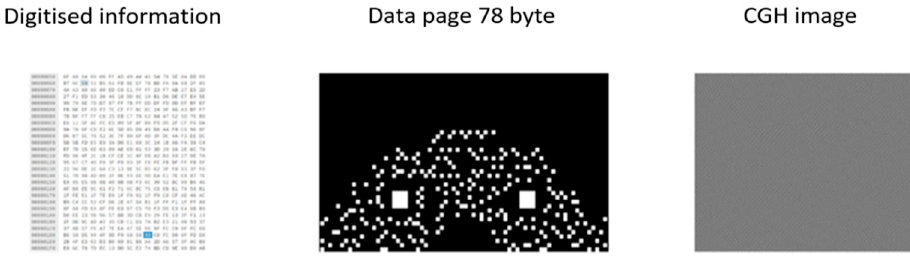
Figure 11. Stages of digital data transformation into CGH.